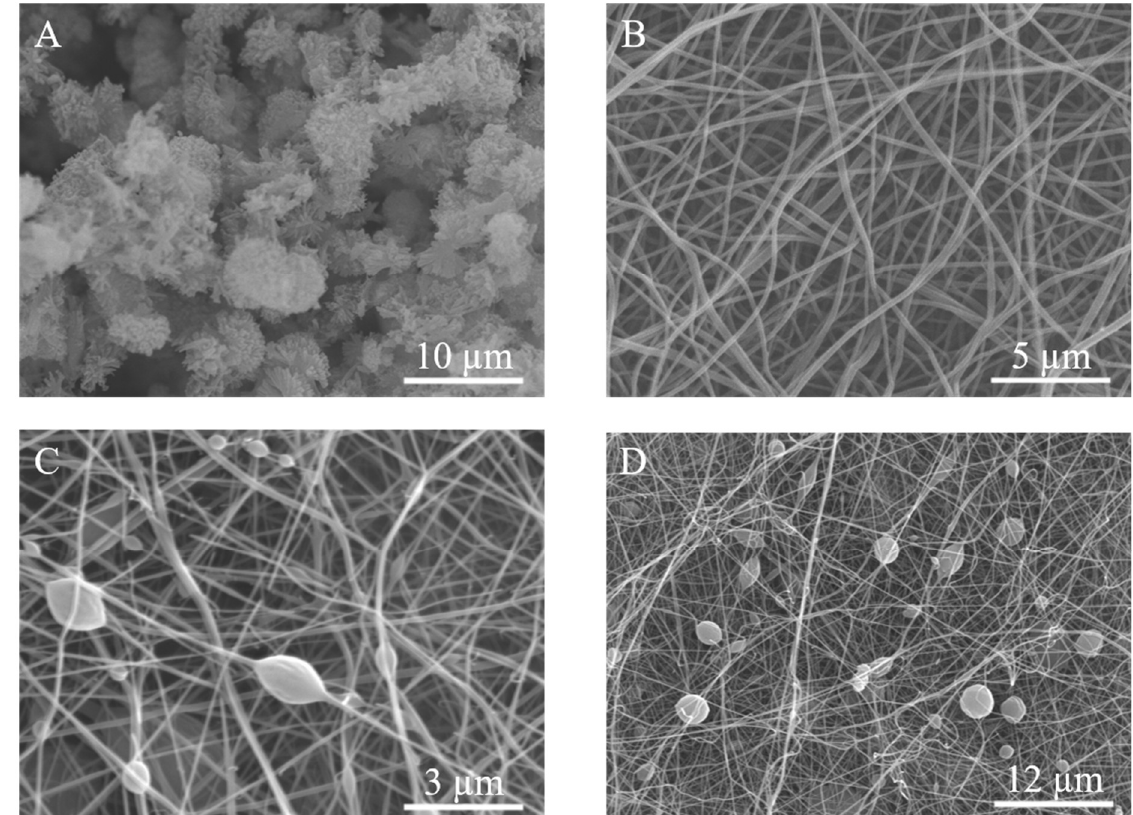
Figure 2. SEM images of TpPa–1 ( A ), pure PAN ( B ), PAN/TpPa–1 ( C , D ) nanofiber. The FT-IR of Tp, Pa–1, and COF TpPa–1 is displayed in Figure 3. It can be seen that the N–H characteristic peak of Pa–1 completely disappeared in TpPa–1, indicating that Pa–1 was completely formed of COF TpPa–1. The characteristic peak of C=O in TpPa–1 exhibited a blue shift relative to Tp (1639 cm −1 ) and merged with the peak of the C=C stretching band at 1582 cm −1 , which was due to the strong hydrogen bond in the keto structure. The peaks at 1256 cm −1 come from C–N stretching. This indicated that TpPa–1 was successfully synthesized and the tautomerism of TpPa–1 tended to form a keto structure instead of an enol structure.